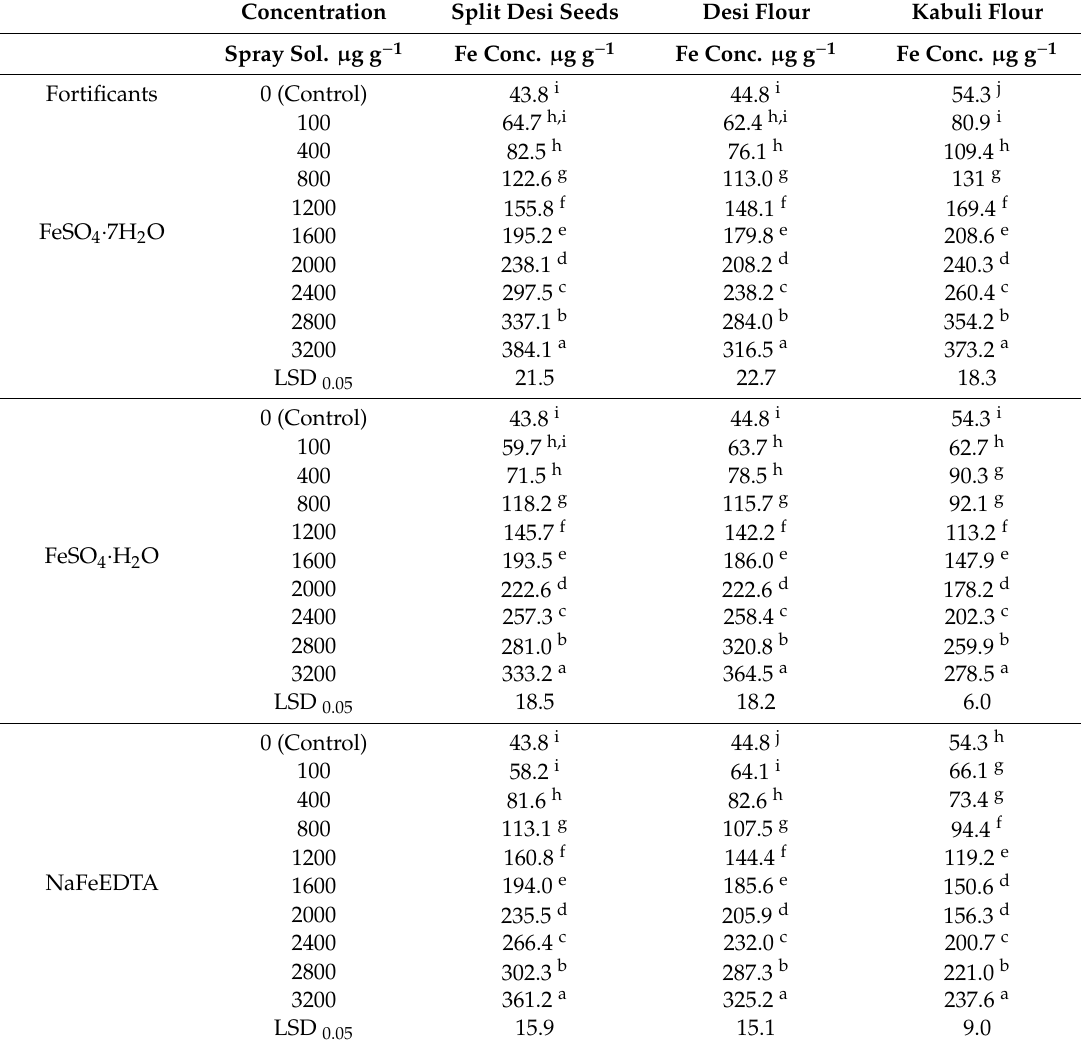
Table 1. E ff ect of three Fe fortificants at nine Fe concentrations on iron concentration in split desi seeds, desi flour and kabuli